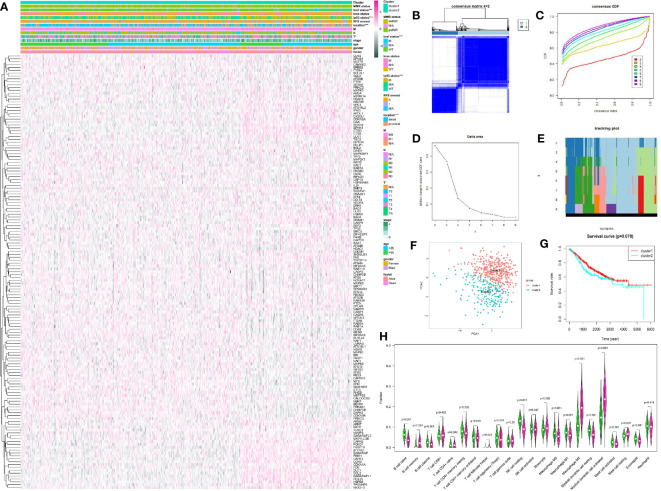
Unsupervised cluster analysis of CRC by R package “ConsensusClusterPlus.” (A) The expression of DEAGs in GEO database and clinical characteristics in two clusters by R package “pheatmap.” (B) Consensus matrix of unsupervised cluster analysis (k = 2). (C) Consensus CDF curve of unsupervised cluster analysis. (D) Delta area under CDF curve of unsupervised cluster analysis. (E) Tracking plot of unsupervised cluster analysis. (F) Principal component analysis of unsupervised cluster analysis. (G) Survival curve of two main clusters. (H) 22 types of immune cells infiltration in the two clusters. Green showed cluster1 and red showed cluster2. *P < 0.05, **P < 0.01, ***P < 0.001, and ****P < 0.0001.